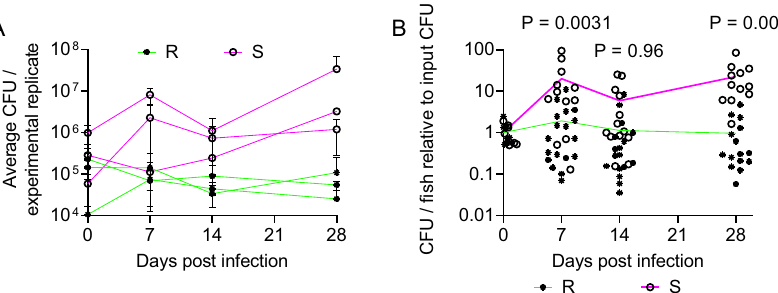
Fig. 1 M. abscessus establishes chronic infection in adult zebra fi sh. A Enumeration of CFUs from adult zebra fi sh infected with either the R or the S variant of M. abscessus . Each point represents a single experimental replicate with at least three animals per timepoint. Total n per timepoint: 0 dpi R = 13 S = 12; 7 dpi R = 18 S = 12; 14 dpi R = 17 S = 13; 28 dpi R = 15 S = 12. B Relative CFUs recovered from adult zebra fi sh infected with either the R or the S variant of M. abscessus . Absolute CFU values were normalised to the inoculum CFU for each experimental replicate. Data are pooled from three replicates per M. abscessus variant. Total n per timepoint: 0 dpi R = 13 S = 12; 7 dpi R = 18 S = 12; 14 dpi R = 17 S = 13; 28 dpi R = 15 S = 12. Statistical tests by two-sided Student ’ s t test at each timepoint. Data are presented as mean values ± SD. Source data are provided as a Source Data